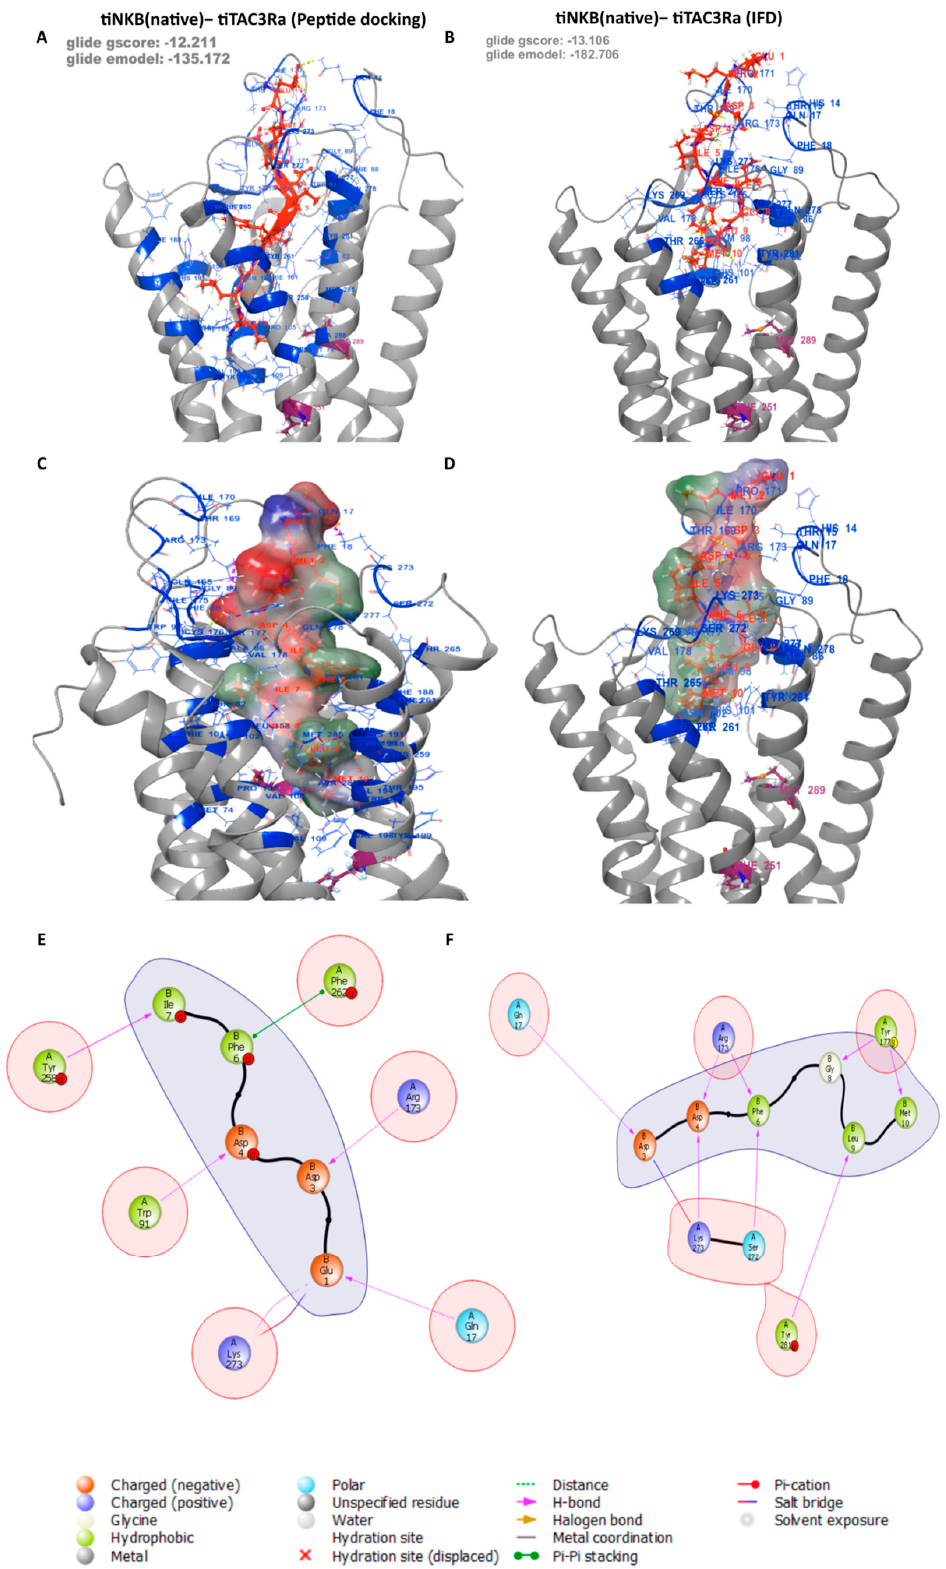
Figure 4. tiNKB docking on tiTac3Ra: Predicted peptide docking of native tiNKB on tiTac3Ra ( A , C , E ), showing IFD between tiNKB-tiTacRa ( B , D , F ) The commonality is a terminal C-terminus with the amino acid sequence Phe—X—Gly—Leu—Met—NH 2 docked to the hydrophobic transmembrane pocket.